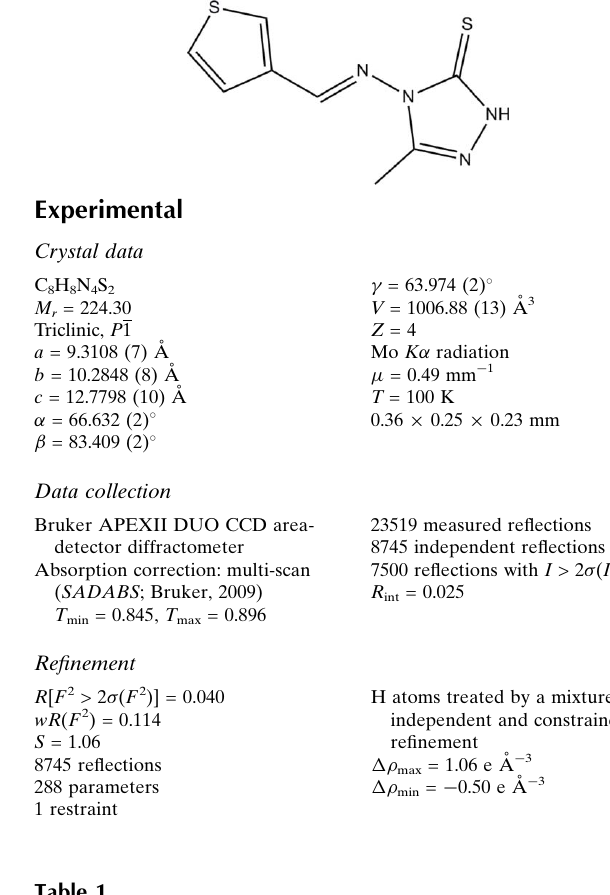
Hydrogen-bond geometry (A˚ , (cid:2) ). D —H (cid:3)(cid:3)(cid:3) A D